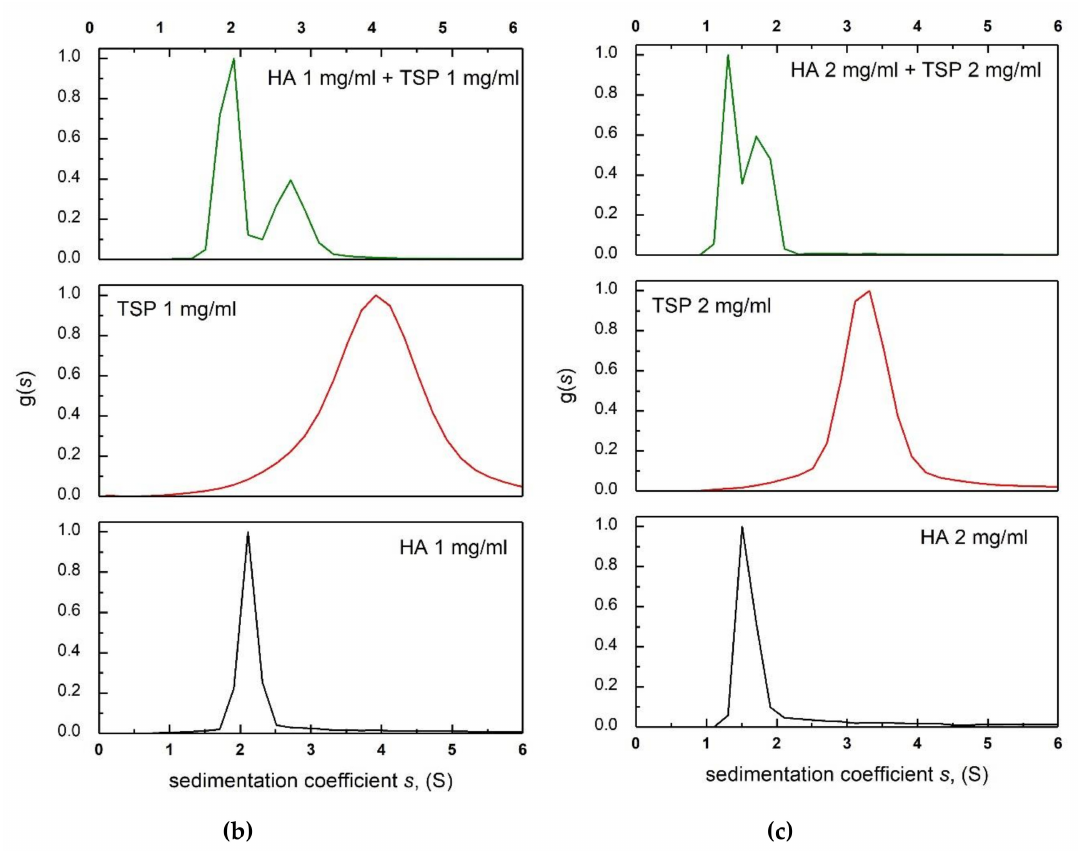
Figure 6. ( a ) Elution profiles for a 1:1 mixture of HA to TSP in 0.1M, pH 6.8 PBS bu ff er. Solid circles—light scattering 90 ◦ signal. Open circles—concentration (refractive index) signal. Dashed line—relative viscosity signal. Concentration of HSA = 1 mg / mL, and TSP = 1 mg / mL. ( b ) Sedimentation coe ffi cient distributions for HA (black), TSP (red) and HA-TSP mixture (green). Concentrations of HA, TSP 1 mg / mL. ( c ) As ( b ) but concentrations of HA, TSP = 2.0 mg / mL.